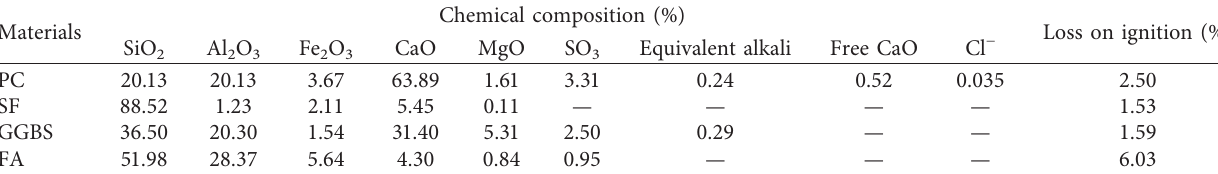
Table 1: Chemical composition of PC, SF, GGBS, and FA.